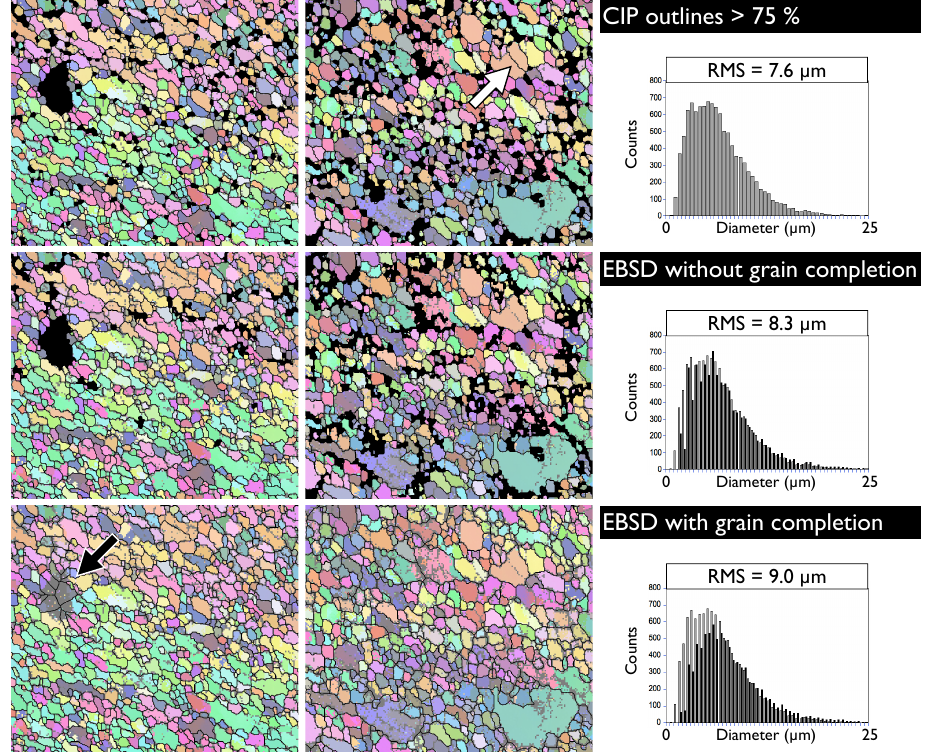
Figure A1. Segmentation based on texture. Comparison of segmentations based on c -axis misorientation and structural filtering (CIP) and on full-texture misorientation (EBSD) with and without grain completion (see text). For each segmentation method, two grain boundary maps are shown superposed on a soft Euler RGB image; on the left an area with relatively low (78%) indexing ratio, on the right an area with relatively high (94%) indexing ratio. The white arrow points to a low-angle grain boundary that is detected through structural filtering. The black arrow points to a segmentation artifact. On the right are frequency distributions, h(d) , where d = diameter of the area equivalent circle. Black bars represent EBSD segmentation and gray bars represent CIP segmentation; root mean square (RMS) values of h(d) are indicated.